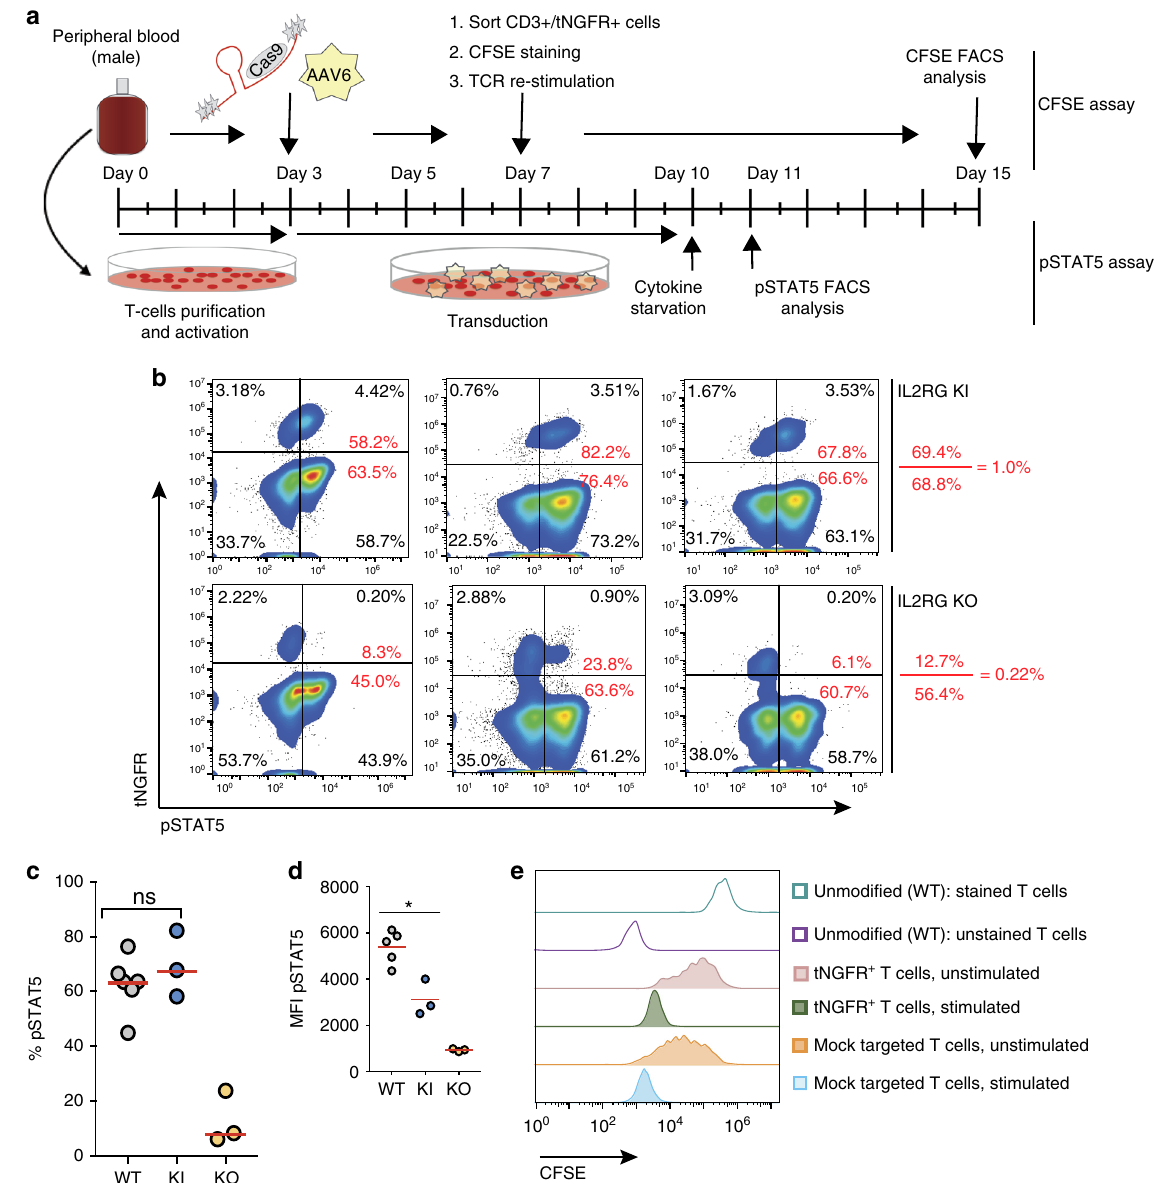
Fig. 5 Evaluation of IL-2 receptor function in IL2RG cDNA targeted T cells. a Schematic of signaling (pSTAT5 — bottom) and proliferation (CFSE — top) in vitro assays. b pSTAT5 assay derived FACS plots. Top: healthy male-derived T cells genome targeted with IL2RG cDNA tNGFR (KI) or with tNGFR + only cassette integrated at the IL2RG endogenous locus (KO). In red are the percent of double positive IL2RG -tNGFR + pSTAT5 + [4.42%/(4/42% + 3.18%)]×100. We compare 58.2% cells (IL2RG targeted T cells) with 58.7% ( IL2RG from WT T cells), ( n = 3 biological replicates). c Quanti fi cation of IL-2R signaling through phosphoSTAT5 pathway. d pSTAT5 MFI for WT, KI, and KO experiments from ( b ) p = 0.02, Welch ’ s t -test. WT T cells (gray circles, n = 6), IL2RG KI (blue circles, n = 3) and IL2RG KO (orange circles, n = 3). e Proliferation pro fi le of CFSE labeled, TCR stimulated IL2RG cDNA tNGFR + sorted or mock-targeted T cells. Mock-targeted T cells are WT T cells cultured for the same amount of time as the tNGFR + targeted cells and have been nucleofected in the absence of RNP or absence of transduction with AAV6. Shown FACS analysis at days 2, 4, 6, and 8. pSTAT5 phosphorylated STAT5, CFSE carboxy fl uorescein succinimidyl ester, KI knocked in, KO knocked out, tNGFR truncated nerve growth factor receptor, IL-2 interleukin 2. Source data are available in the Source Data fi